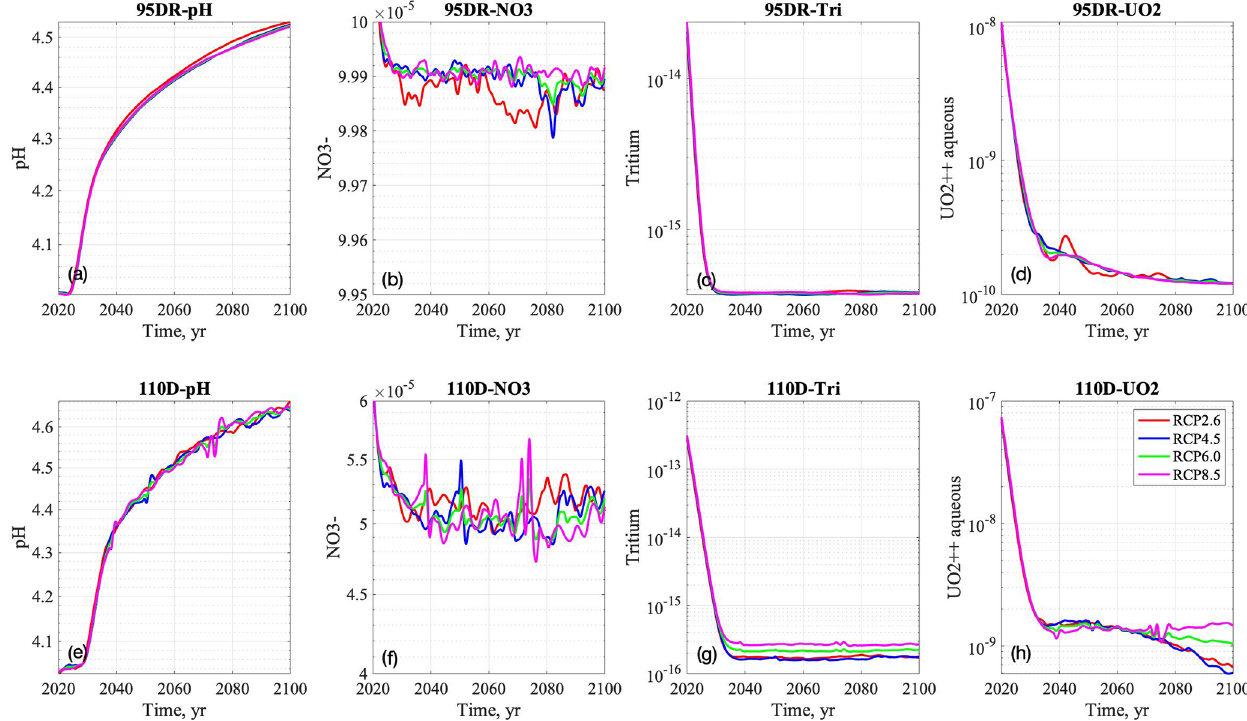
Figure 12. Breakthrough curves of pH, nitrate, tritium, and aqueous uranium at the source-zone well (a–d) and downgradient well (e–h) in the climate scenarios from 2020 to